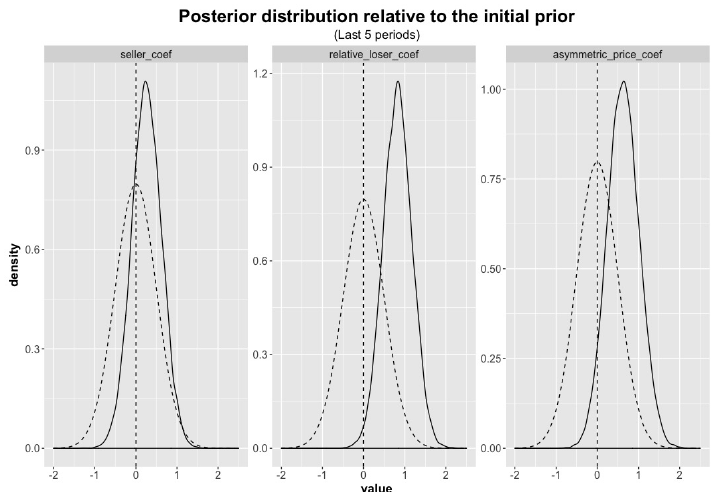
Figure 4. The distributions shown with dashed lines are the imposed effect prior, centered around 0. The solid line distributions show the posterior distribution, which is the updated effect distribution that conditions on the observed data from the last 5 rounds of the